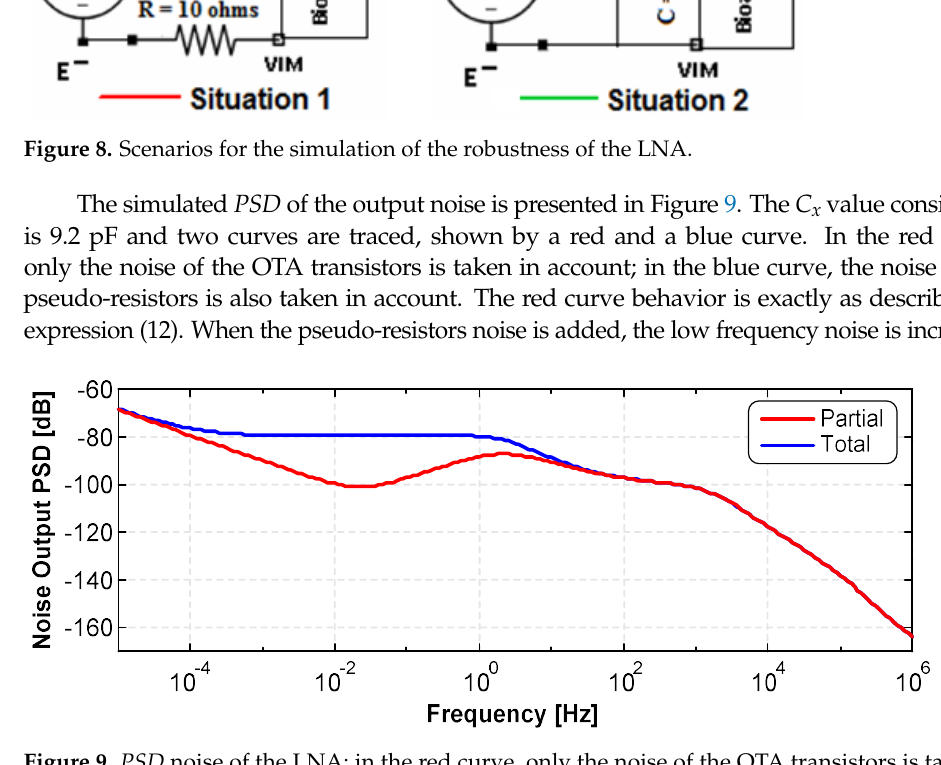
Figure 9. PSD noise of the LNA: in the red curve, only the noise of the OTA transistors is taken in account; in the blue curve, the noise of the pseudo-resistors is also taken in account.